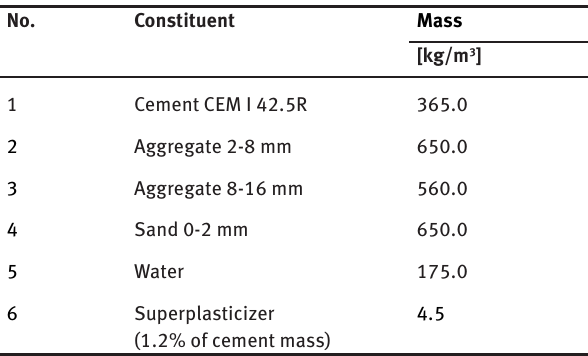
Table 1: Design of concrete mix used to make tested cylindrical